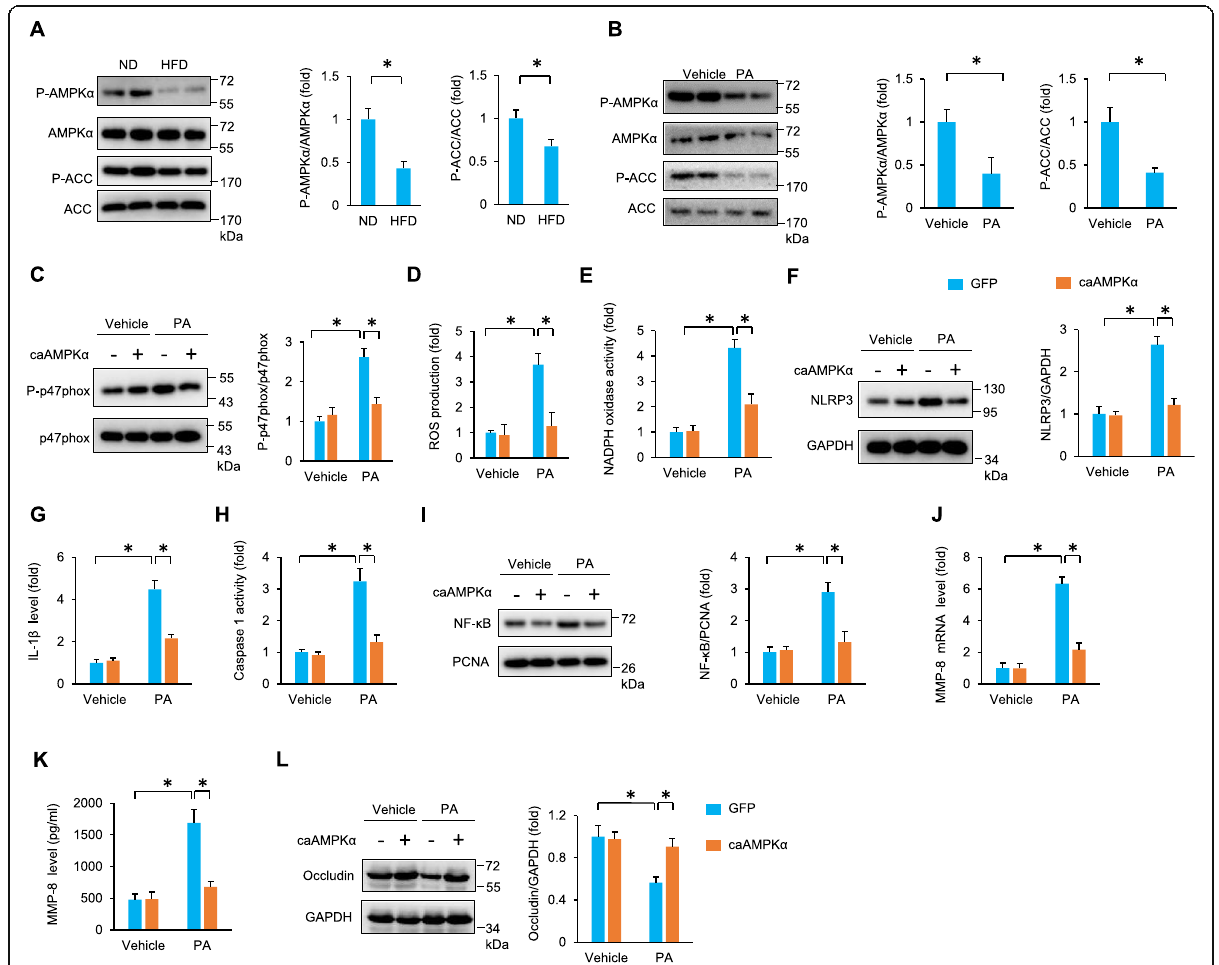
Fig. 6 Constitutively active AMPK α attenuated palmitic acid-induced impairment of SCs in vitro. A , B The protein expression of AMPK α and ACC ( n = 6). C The protein expression of p47phox in PA-treated TM4 cells at 24 h after caAMPK α infection ( n = 6). D , E The production of ROS and NADPH oxidase activity in PA-treated TM4 cells at 24 h after caAMPK α infection ( n = 6). F – H The NLRP3 and IL-1 β levels and caspase 1 activity in PA-treated TM4 cells at 24 h after caAMPK α infection ( n = 6). I The nuclear NF- κ B accumulation in PA-treated TM4 cells at 24 h after caAMPK α infection ( n = 6). J , K MMP-8 expression in PA-treated TM4 cells at 24 h after caAMPK α infection ( n = 6). L The protein expression of occludin in PA-treated TM4 cells at 24 h after caAMPK α infection ( n = 6). Data are presented as the mean ± SD. For A , B , the statistical analysis was carried out by Student ’ s two-tailed t test; for others, the statistical analysis was carried out by one-way ANOVA. * P < 0.05 vs the matched